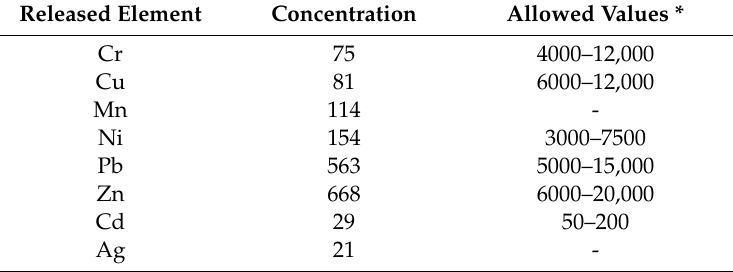
Table 4. Concentration of the released elements after the leaching test. Concentration is expressed in µ g / dm 3 .